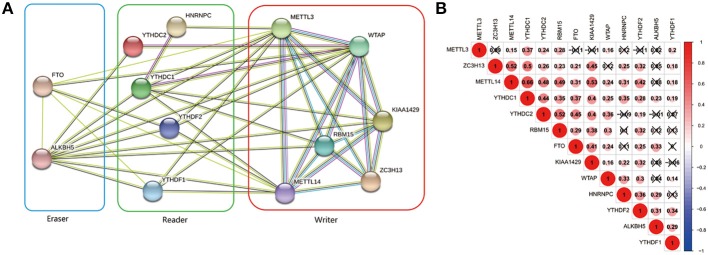
Interaction among m6A RNA methylation regulators. (A) The PPI network of the 13 m6A methylation regulators constructed using STRING. (B) Spearman correlation analysis of the 13 m6A methylation regulators.